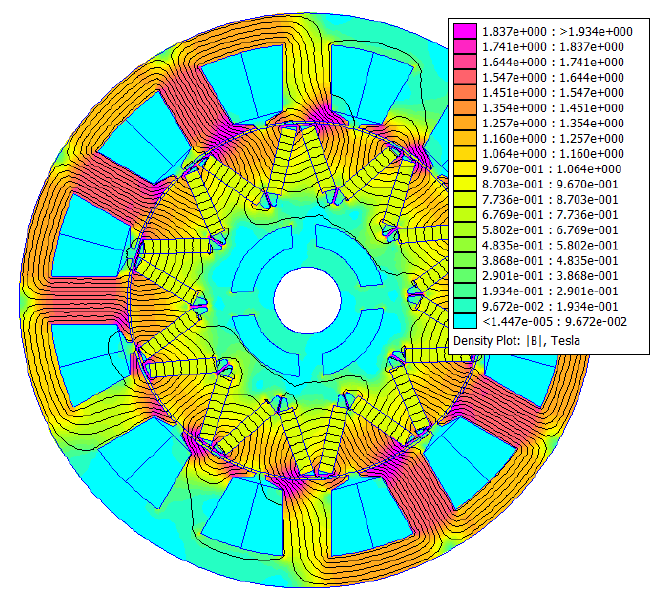
◦ . − 3 A, and θ i = 0 Figure 5. The flux lines and flux density at i q = 10 A, i d = −3 A, and θ i = 0°. Figure 5. The flux lines and flux density at i q = 10 A, i d = The results of FEA are obtained as functions of currents i d and i q as well as θ i . The currents i d and i q are changed from − 25 to 0 A (26 points) and from 0 to 25 A (26 points), respectively. The current step is 1A. θ i is changed from 0 ◦ to 72 ◦ insteps of 1 mech ◦ (73 points). Therefore, it requires (26 ∗ 26 ∗ 73 = 49,348) solutions to generate the full magnetic characteristics for the tested machine motor. The symmetry of the magnetic machine structure helps greatly to reduce the time and/or number of solutions either by plotting part of the machine or by choosing part of the rotor